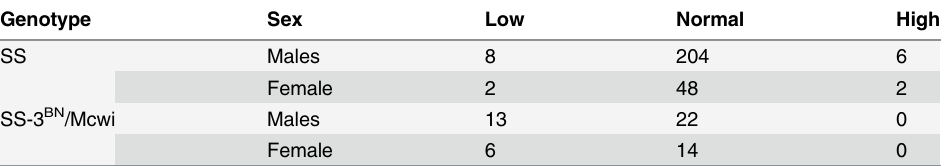
Table 2. Reclassification of records from the rat dataset as low, normal and high relative to the natural variation (95%) in the control